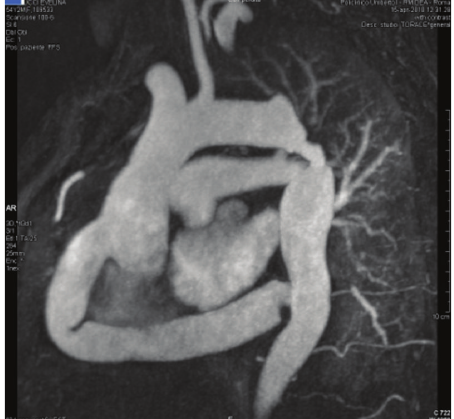
Figure 2: Six-month MR: extra-anatomical bypass from ascending to descending